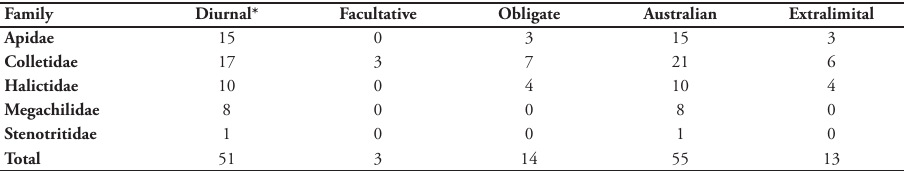
Table 1. The number of diurnal, facultative and low-light species examined by family and the number of Australian and extralimital species examined by family. *There are no available behavioural data to suggest that these species are other than